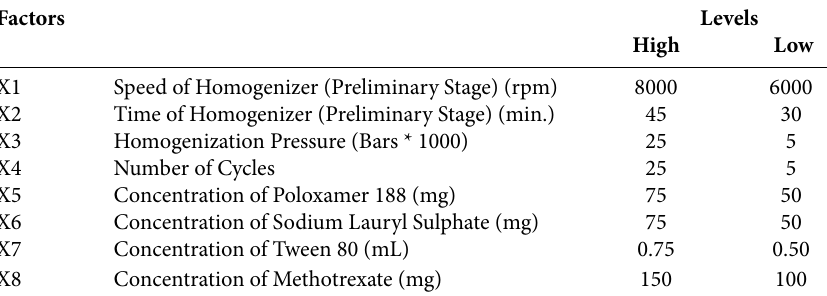
Table 1. Plackett–Burman Design with independent variables and their responses Factors